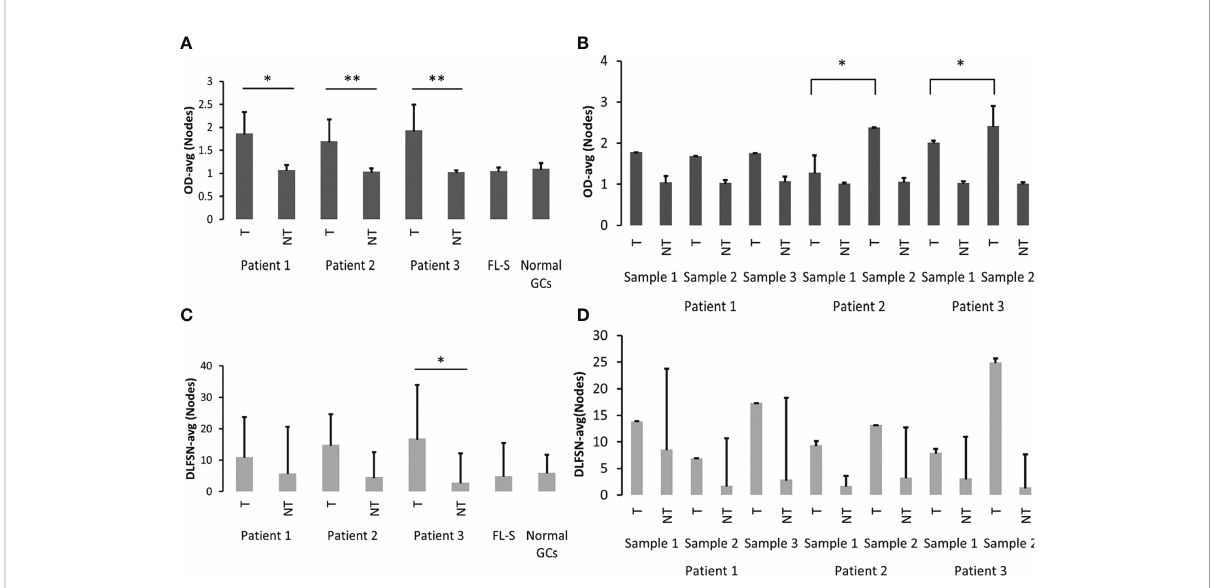
FIGURE 5 Lineage tree topologies. (A) Outgoing degree (OD-avg) of tumor and non-tumor clones of the three FL-HTS patients, FL-S and healthy GC samples. (B) OD-avg of tumor and non-tumor clones in each sample from all three FL-HTS patients. (C) The average distance from a leaf to the fi rst split node/fork (DLFSN-avg) of tumor and non-tumor clones of the three FL-HTS patients, FL-S and healthy GC samples. (D) DLFSN-avg of tumor and non-tumor clones in each sample in each of the three FL-HTS patients. *p-value < 0.05; **p-value <